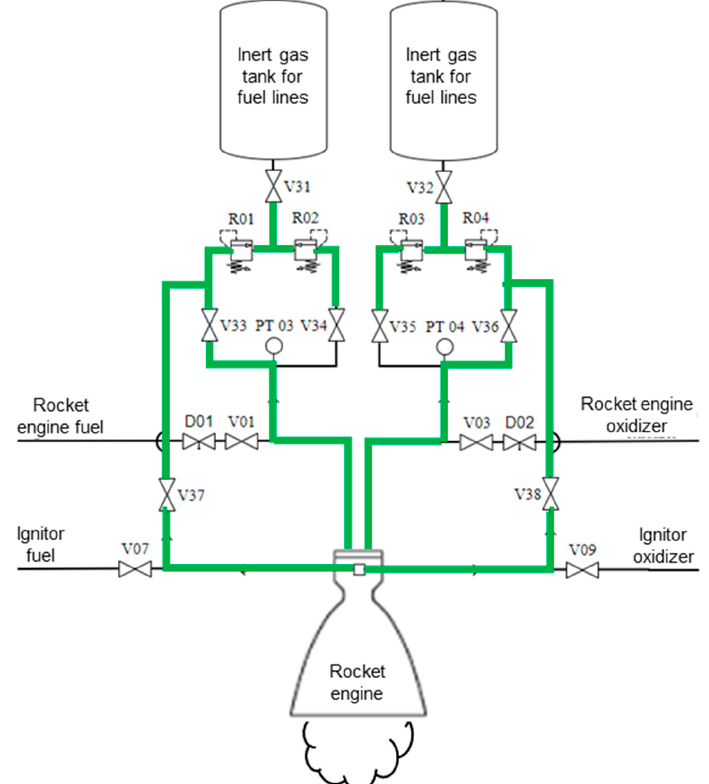
Figure 17. Algorithm’s fifth step diagram.